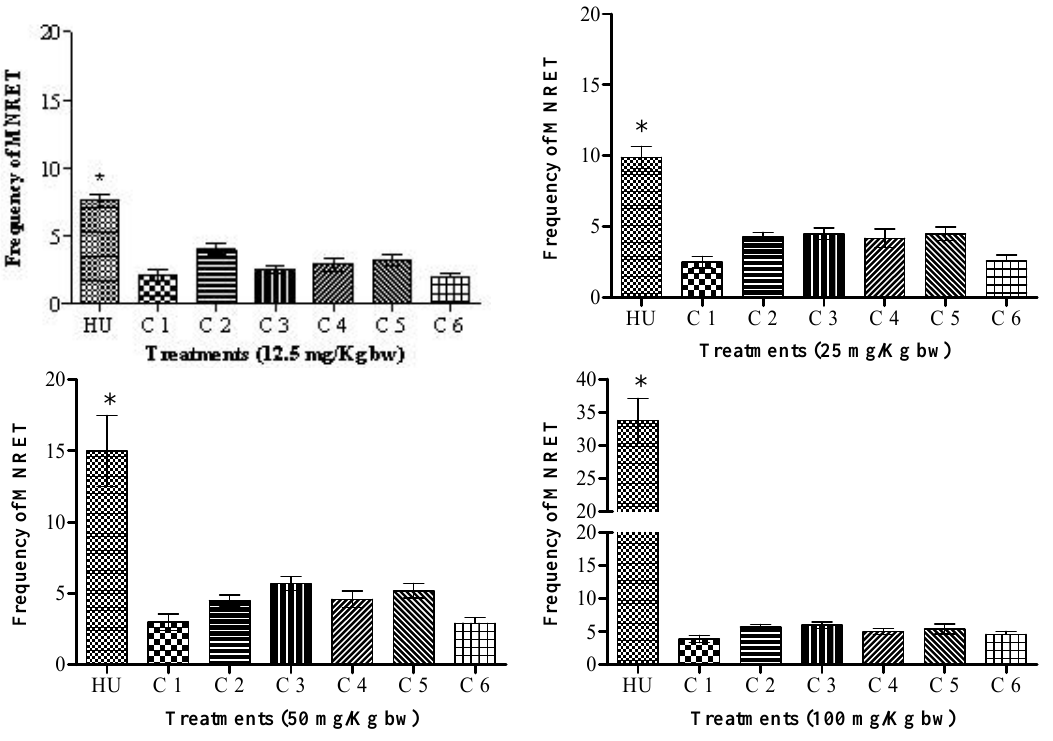
Figure 2. Average frequency of micronucleated reticulocytes (MNRET) and standard deviation of 1,000 cells from mice treated with the drug hydroxyurea (HU) and all the synthesized compounds C1-C6 at different concentrations. *P < 0.05.